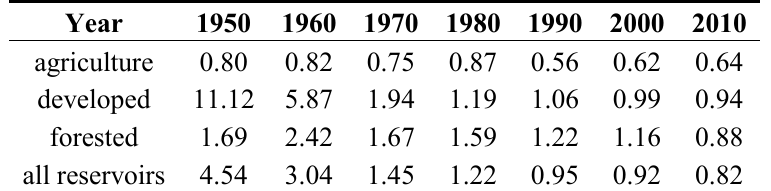
Table 3. Classified by adjacent land cover, average reservoir surface area (km 2 ) across all 20 study